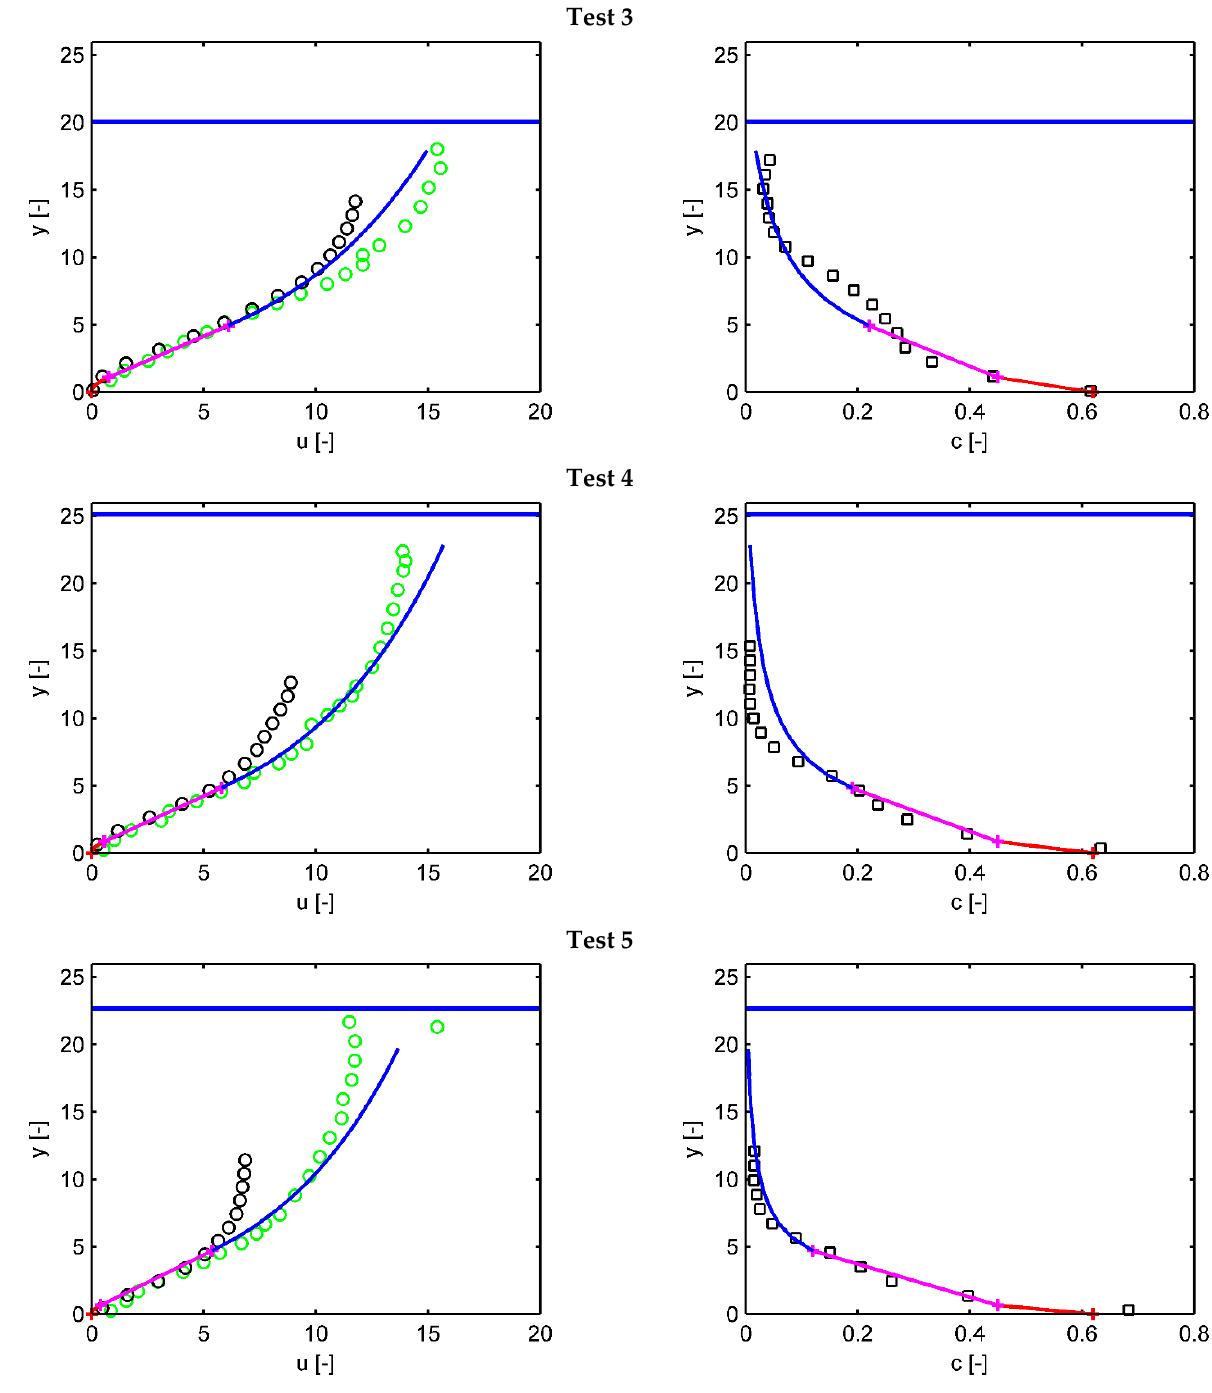
Figure 4. Profiles of velocity (left panels) and concentration (right panels) in Tests 1–5 for flow with transported SUN25 particles in tilting flume (all quantities are dimensionless). Legend: Black circle—stereoscopic measurement; green circle—Prandtl tube measurement; black square—laser-stripe measurement; red line—model prediction in permanent-contact layer; magenta line—prediction in combined-load layer; blue line—prediction in suspended-load layer; horizontal blue line—water surface.